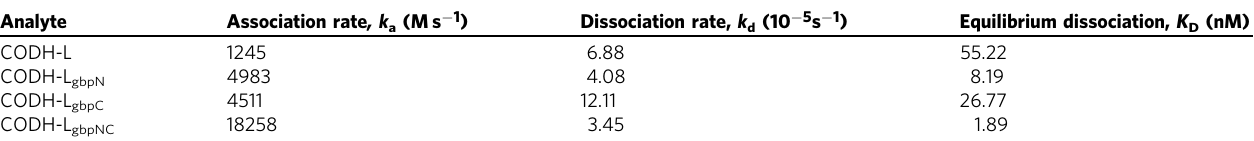
Table 2 Binding kinetics of the native and synthetic CODH-Ls as determined by SPR